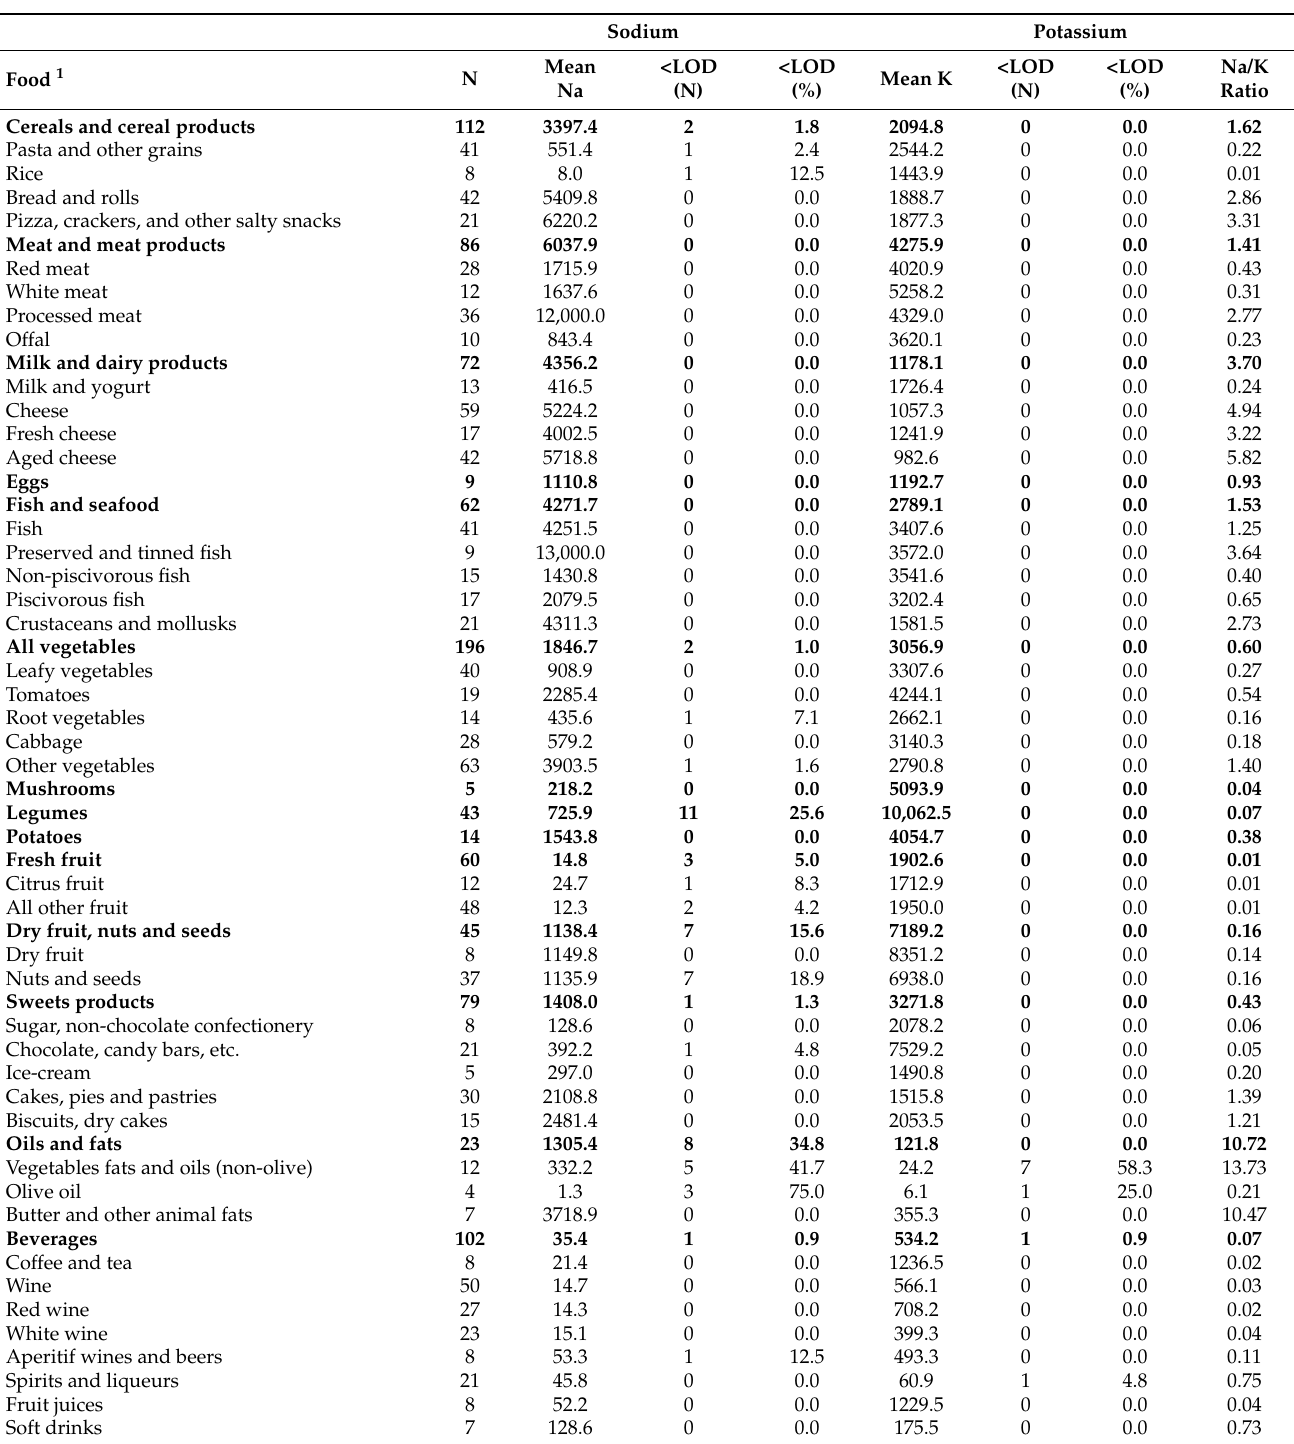
Table 2. Average content (mg/kg wet weight) of sodium (Na) and potassium (K) in foods and number (%) of samples below the limit of detection